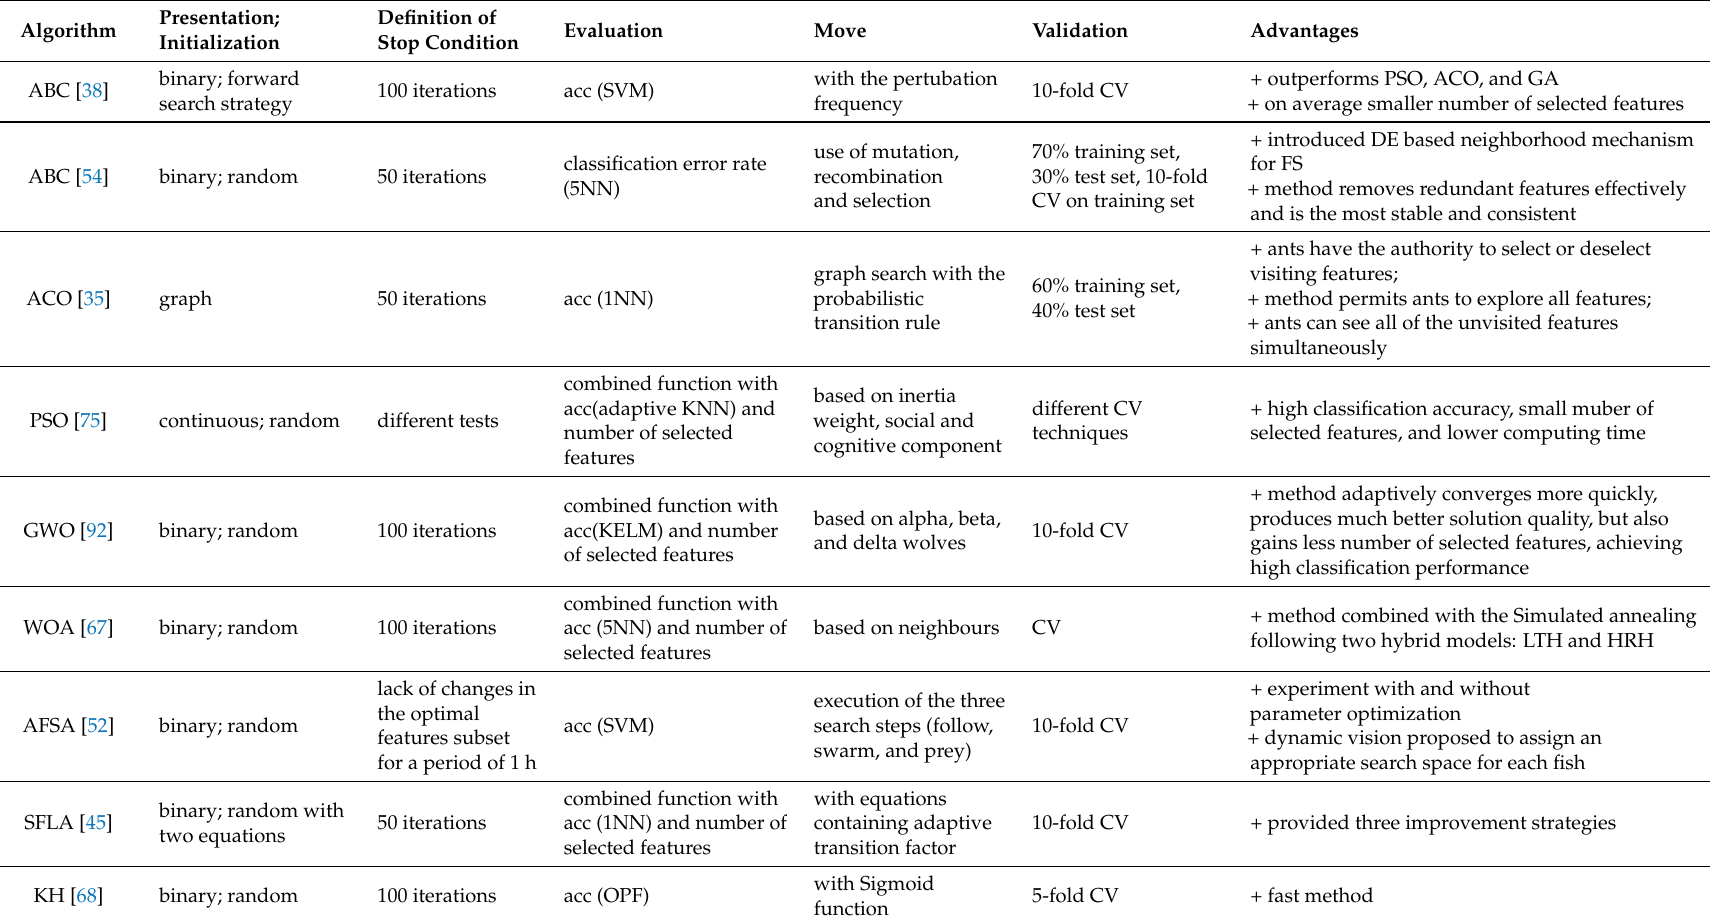
Table 5. Summary of selected algorithms and their components sorted by proposed